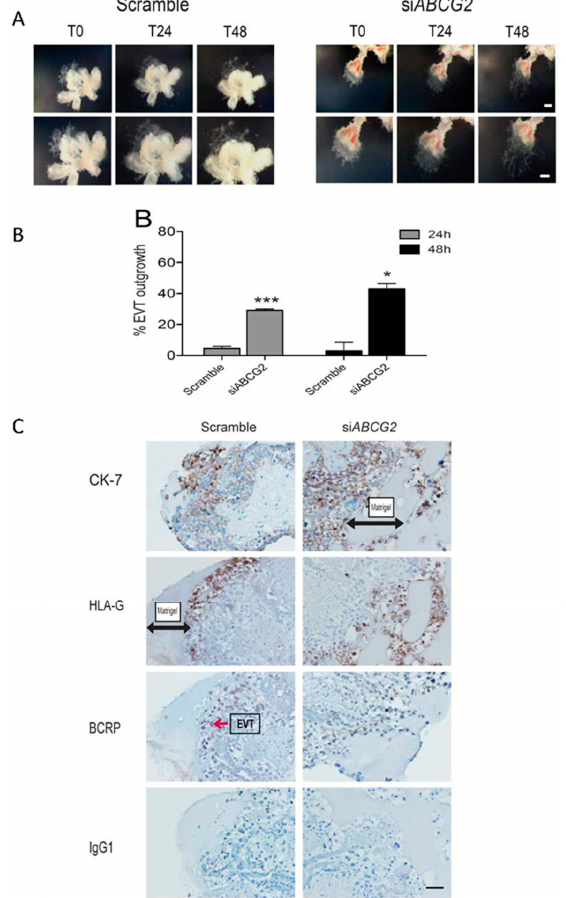
Figure 7. ABCG2 knockdown stimulated EVT cell migration in human placental explants. ( A ) Representative images of 7-week placental explants treated with Scrambled (control) siRNA